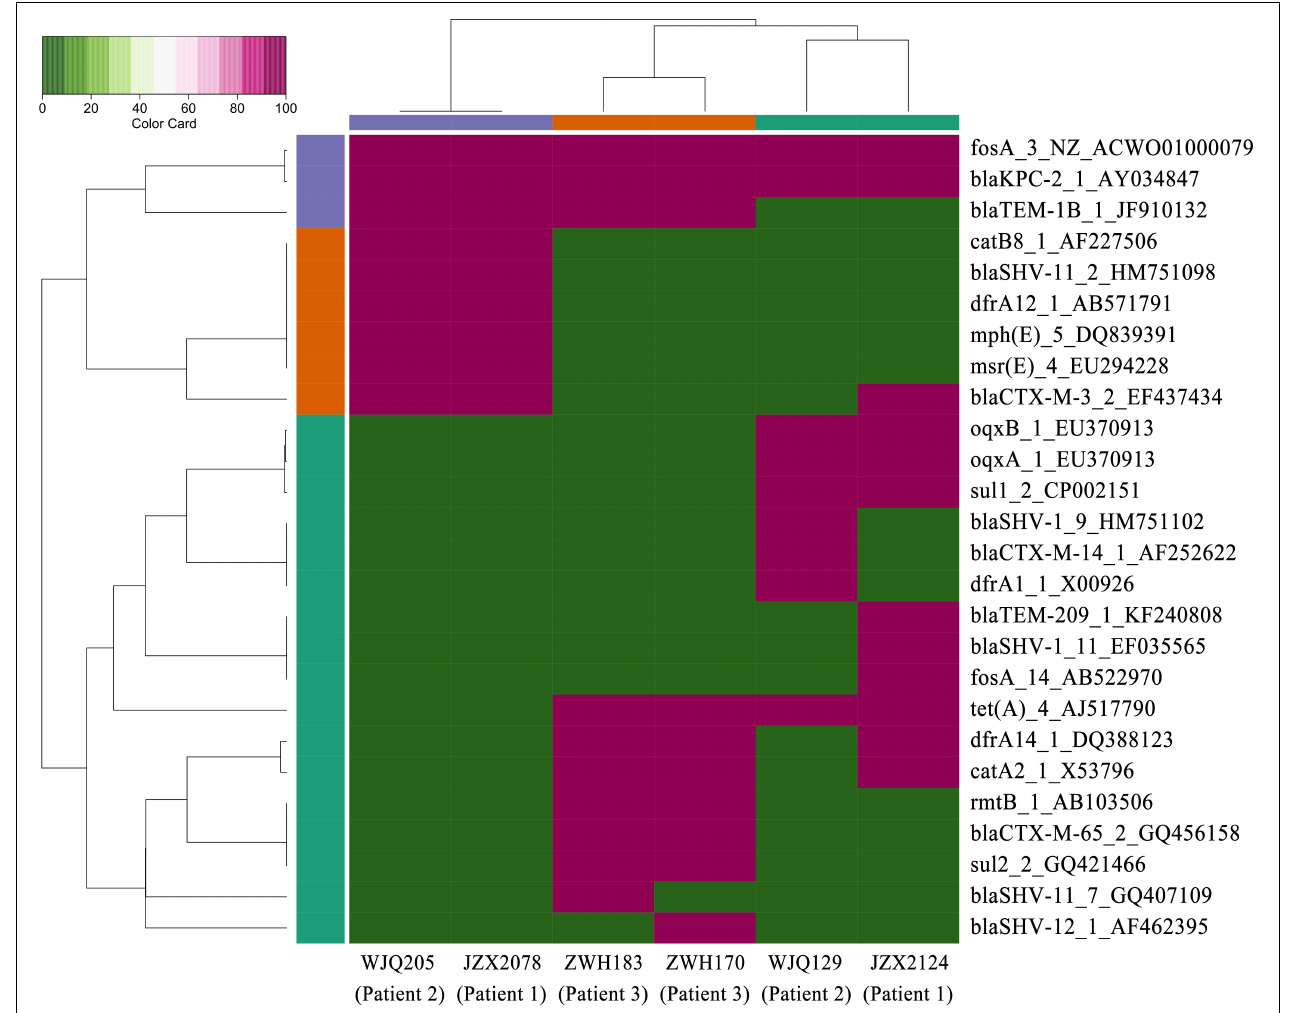
FIGURE 3 | Heatmap of antimicrobial resistance genes in the CRKP isolates from stool samples. Red and green boxes indicate the presence and absence of the corresponding antimicrobial resistance genes,